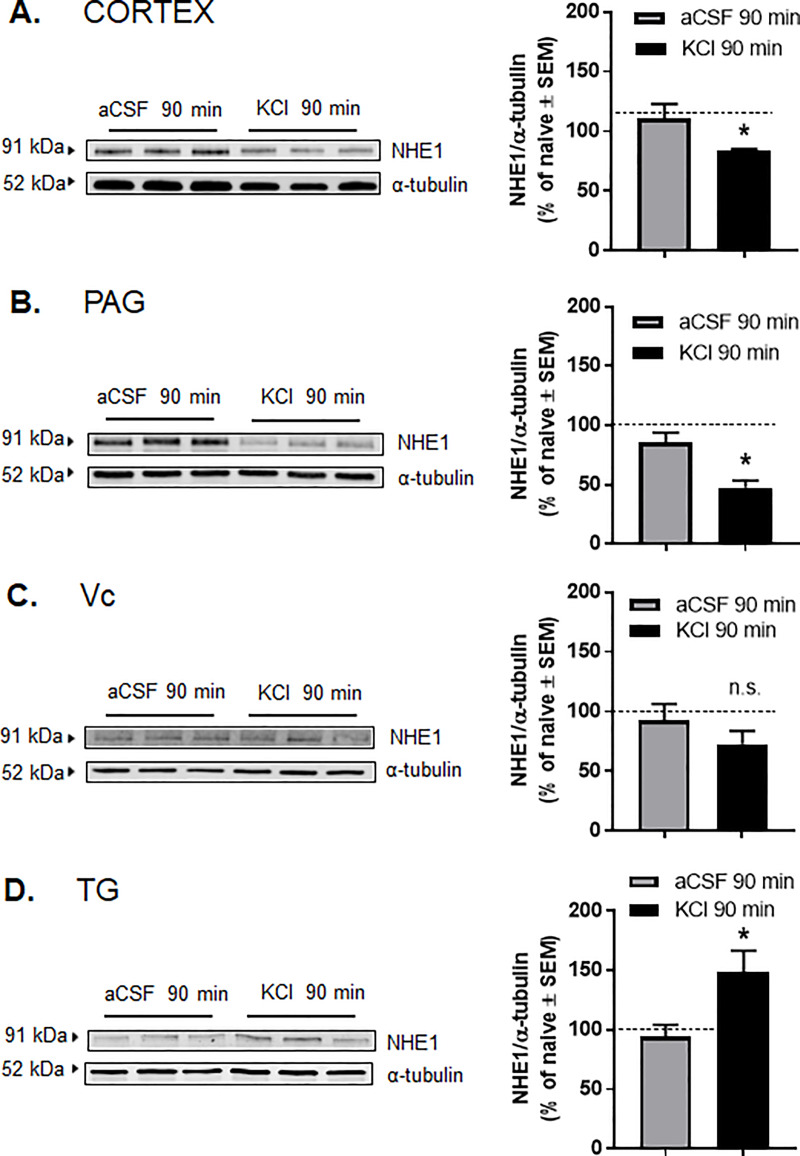
Total expression of NHE1 was decreased in cortex and PAG samples at 90 min after dural manipulation.(A-D) Representative immunoblots indicating NHE1 and α-tubulin as a loading control in pain nuclei engaged in spreading depression, namely cortex (A), PAG (B), Vc (C), and TG (D). Samples were harvested 90 min after cortical aCSF or KCl injections. All data represent the % of naïve relative expression ± SEM (n = 3, loaded in duplicate). The dashed line indicates the relative expression of NHE1 in naïve samples. No significant differences were observed between naïve and aCSF-treated samples. * denotes significantly different (p<0.05), as assessed by one-way ANOVA.